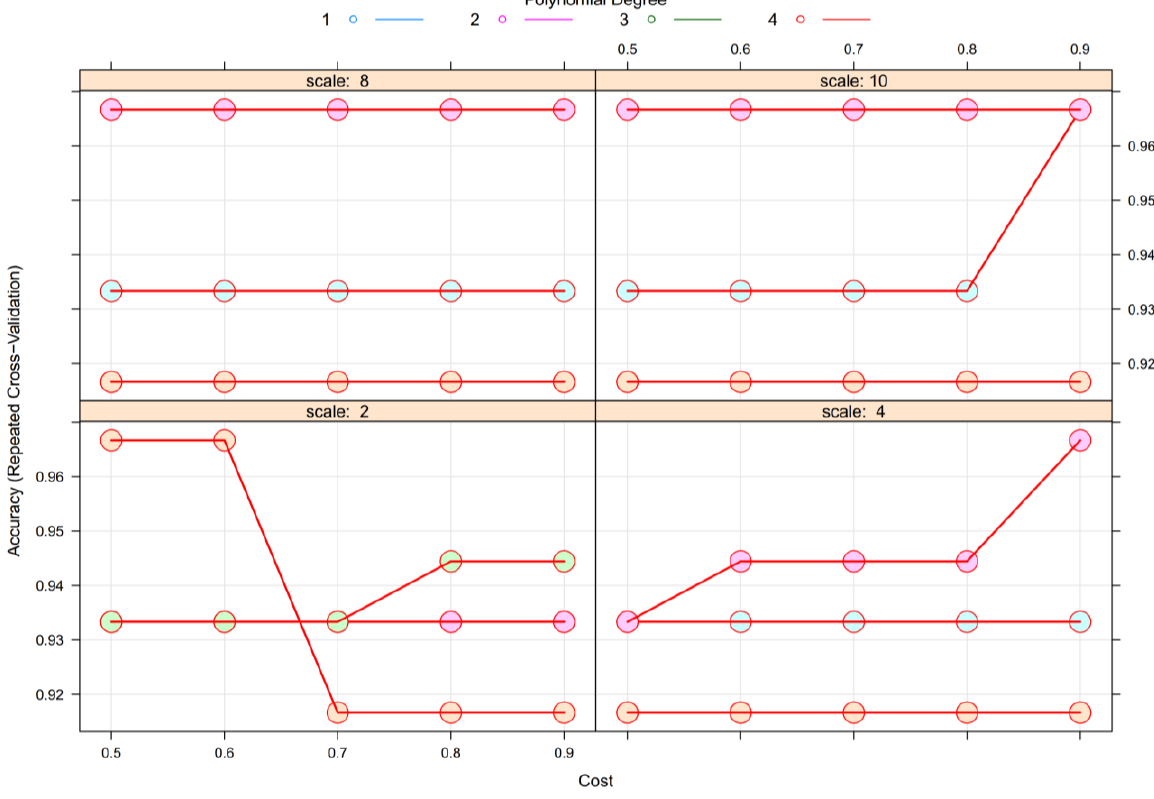
Figure 4. SVM Polynomial